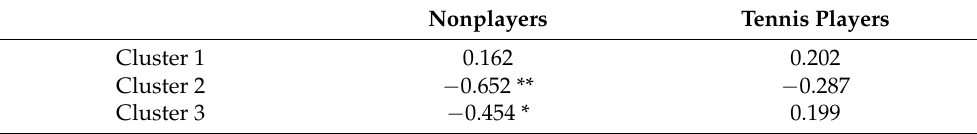
Table 6. Correlation between age and Cluster 1, Cluster 2, and Cluster 3.